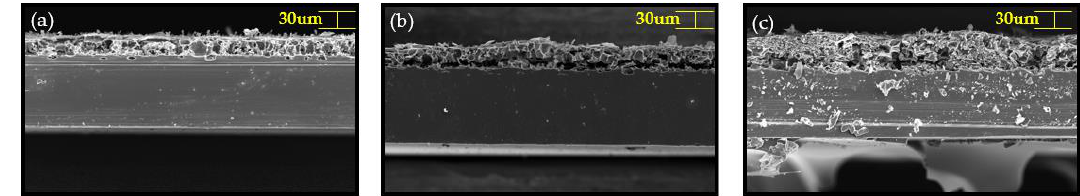
Figure 6. FE-SEM transection images of patterns: ( a ) patterns fabricated at 60 mm/s, ( b ) patterns fabricated at 40 mm/s and ( c ) patterns fabricated at 20 mm/s. Table 4. Thickness of overlapped-pulse patterns.